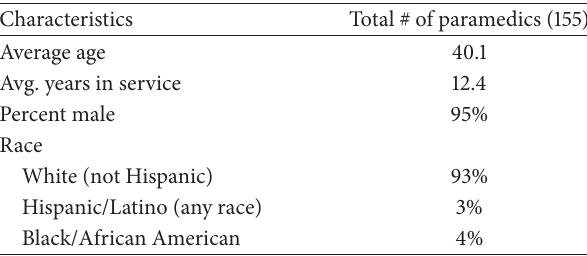
Table 1: Alachua county fire rescue paramedics’ descriptive statis-